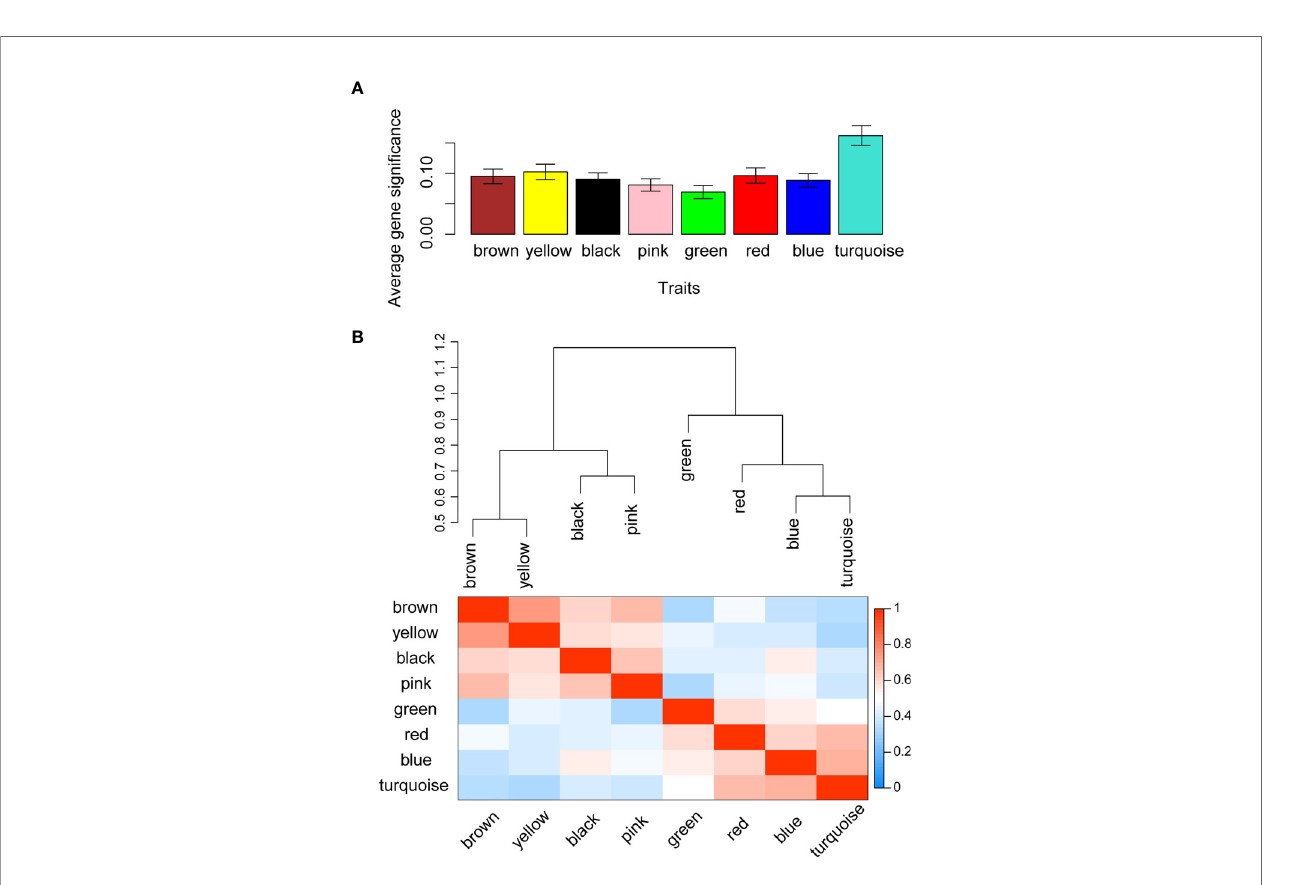
FIGURE 10 | Gene co-expression module identi fi cation and correlation analysis. (A) Distribution of average gene signi fi cance in the modules related with radiomic risk scores. The y-axis represents the signi fi cance values. (B) The heat map of the correlation between gene